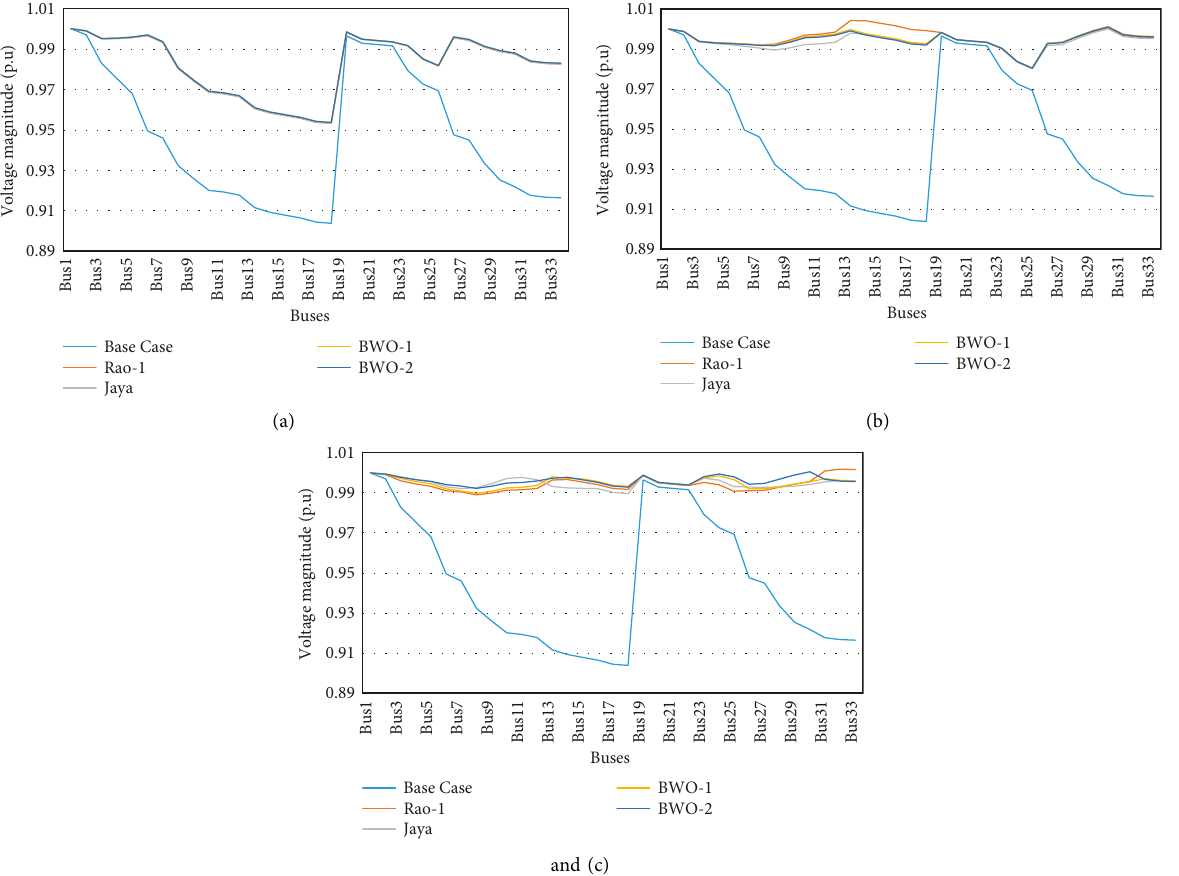
Figure 11: Comparison of bus voltages for the IEEE 33-bus test system with the simultaneous allocation of (a) 1DG and 1SC, (b) 2DGs and 2SCs, and (c) 3DGs and 3SCs.